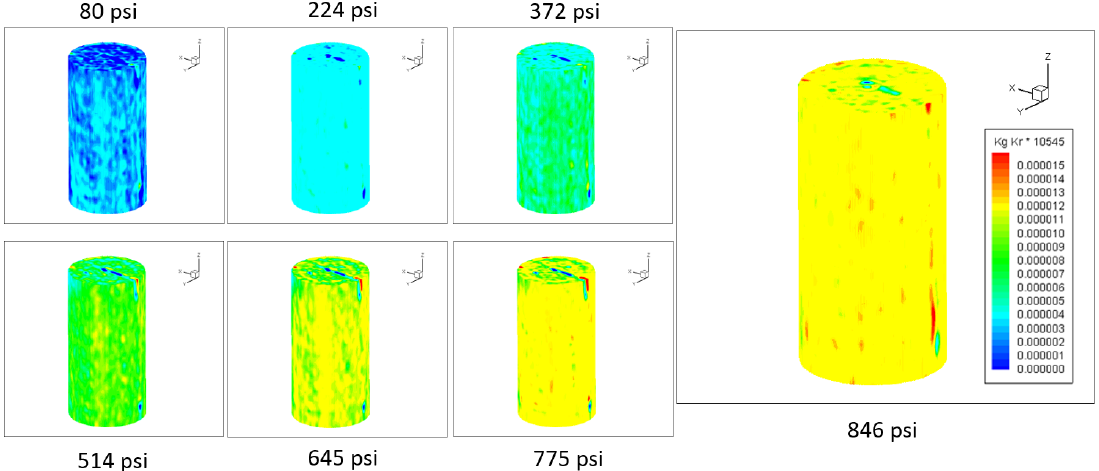
Figure 6. 3D CT images showing increasing Kr storage in the rock with pore pressure in the Eagle Ford sample. The color scale represents the mass of Kr in each voxel in Kg multiplied by the total number of voxels per slice, 10,545. Warmer colors indicate more gas in place.